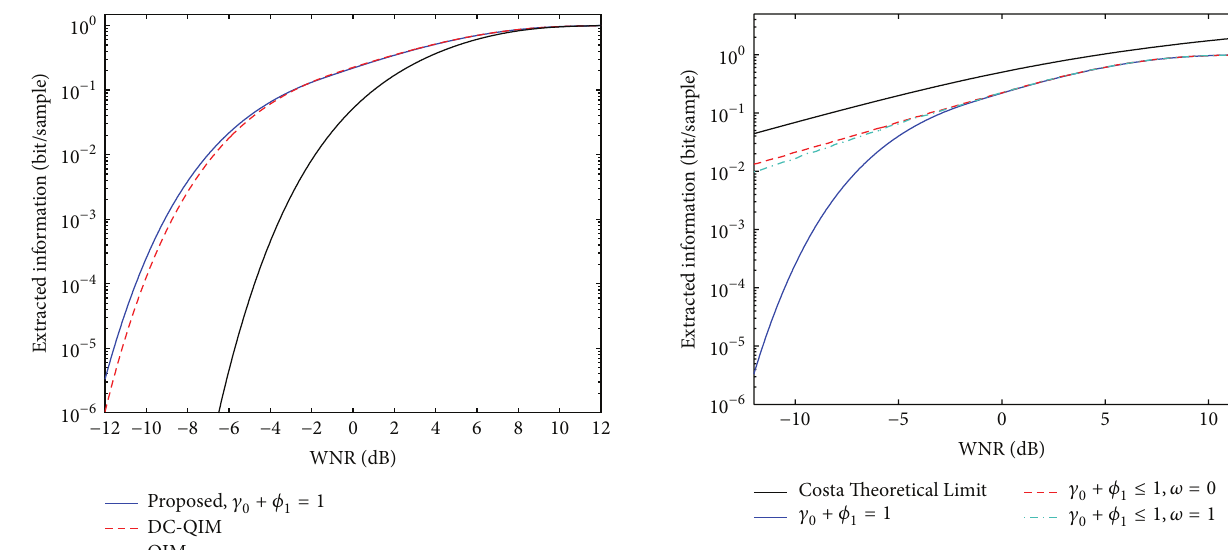
Figure7:Analytic-basedestimationofinformationextractedunder AWGN with